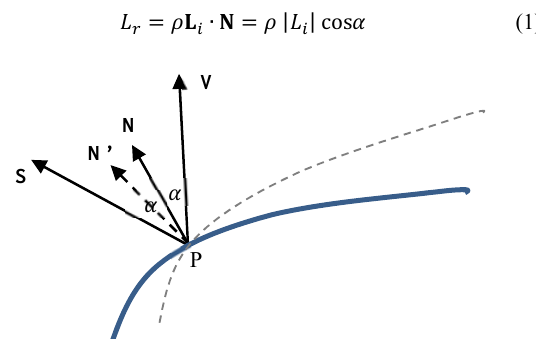
Figure 7. Geometry of specular reflection, showing distortion of the normal vector.